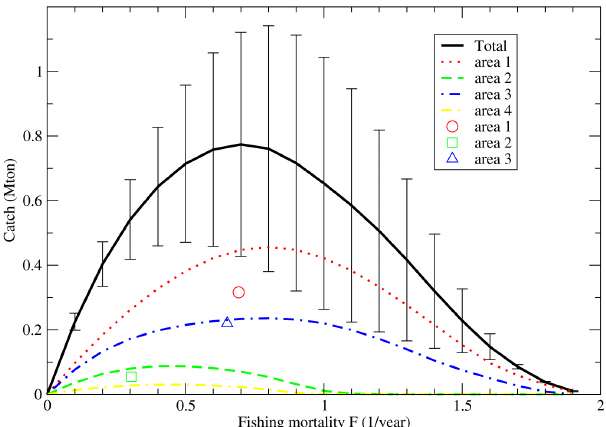
Fig. 10. MSY determination, applying same fishing mortality to all 1 + age groups. Error bars on total catch lines displays interannual total catch variability (RMS). Symbols show catch and fishing mor- tality (plainly averaged for the period 1990–2011) for each